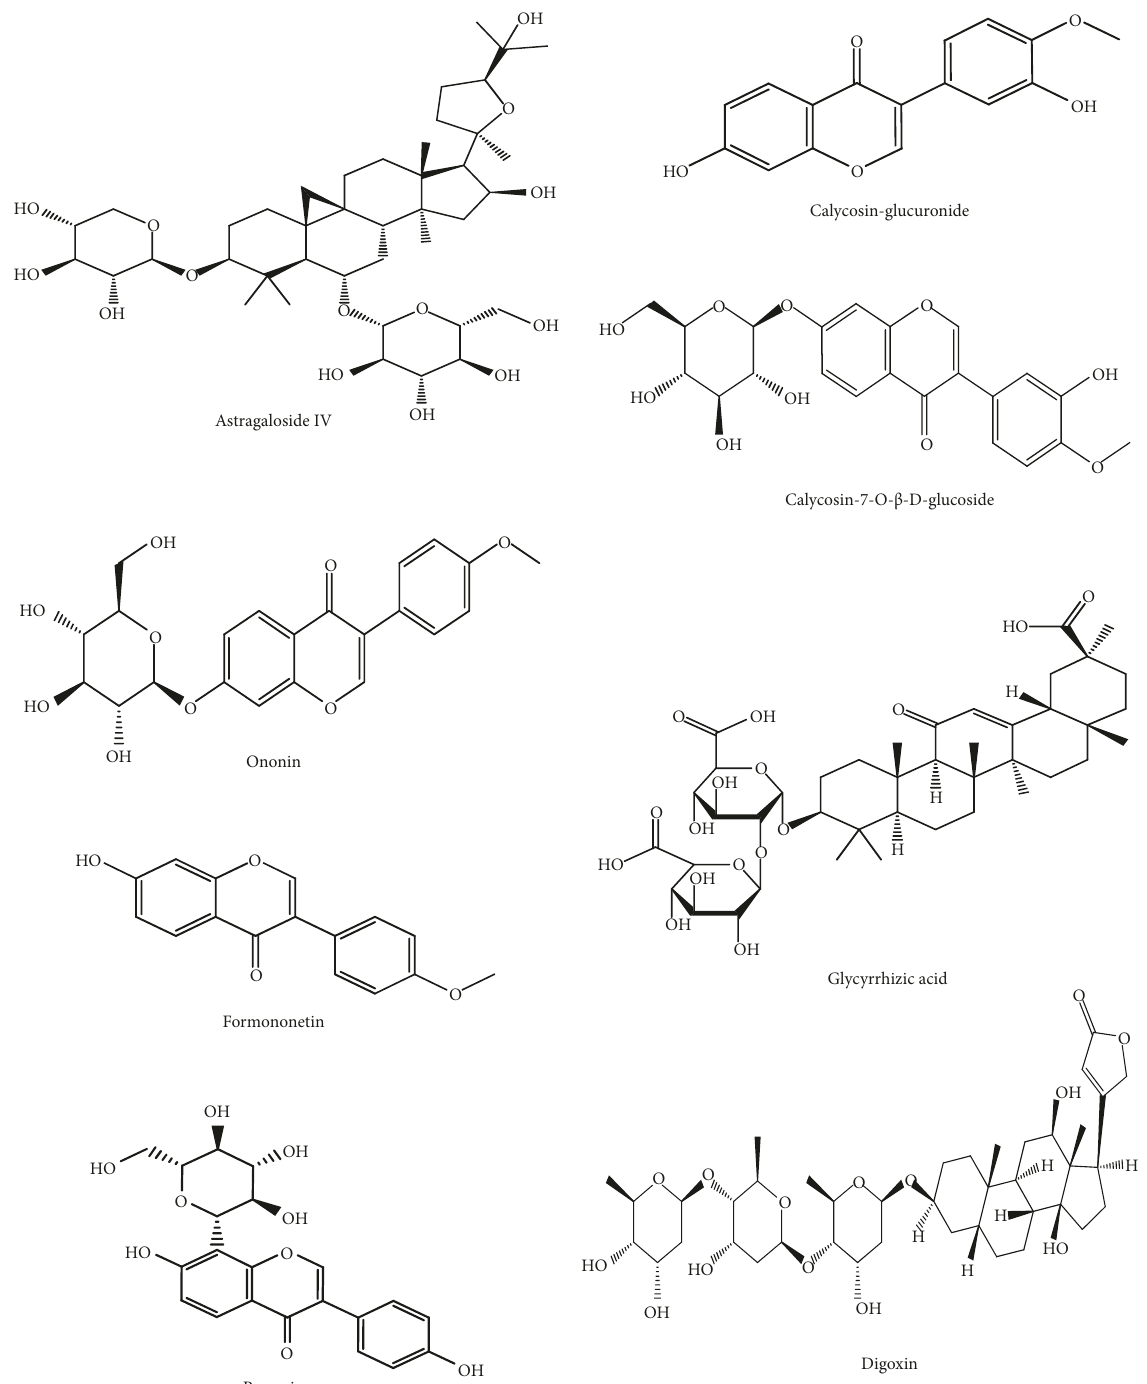
Figure 1: The chemical structure of six